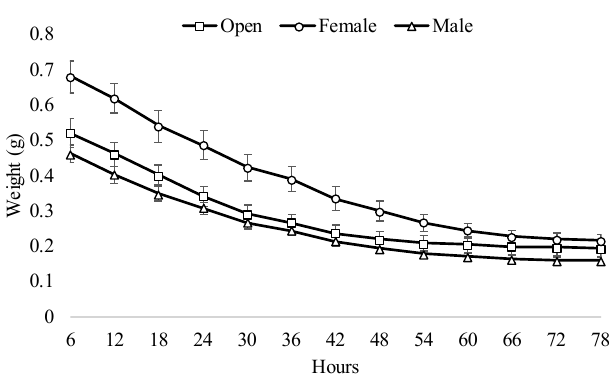
Fig 3 . Fruit weight loss among open, female and male pollinated fruits after 6 to 78 hours of